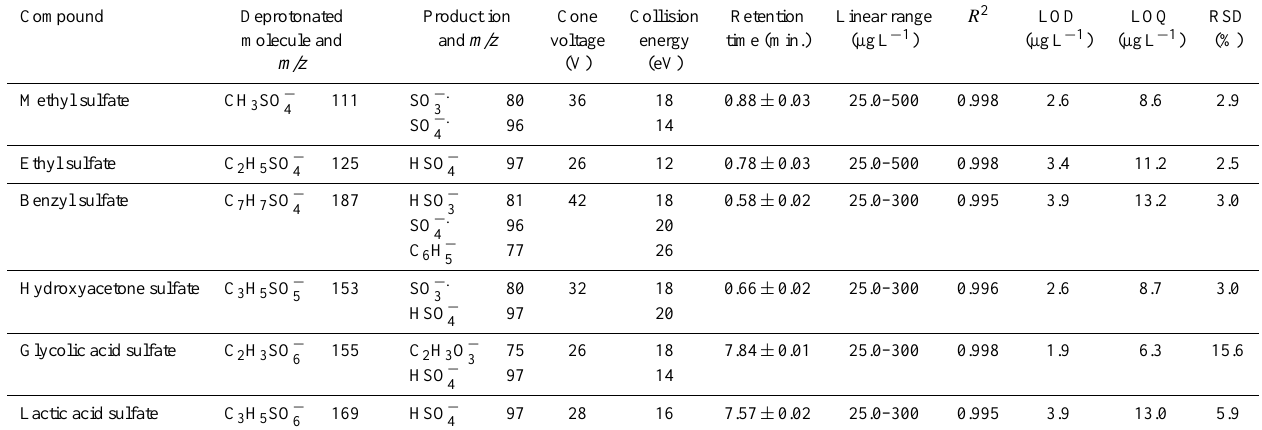
Table 1. MS parameters for MRM transitions of UPLC-MS/MS, linearity, coefficient of determination ( R 2 ), limit of detection (LOD), limit of quantification (LOQ), and relative standard deviation (RSD) of seven replicate standard injections. Compound Deprotonated Product ion Cone Collision Retention